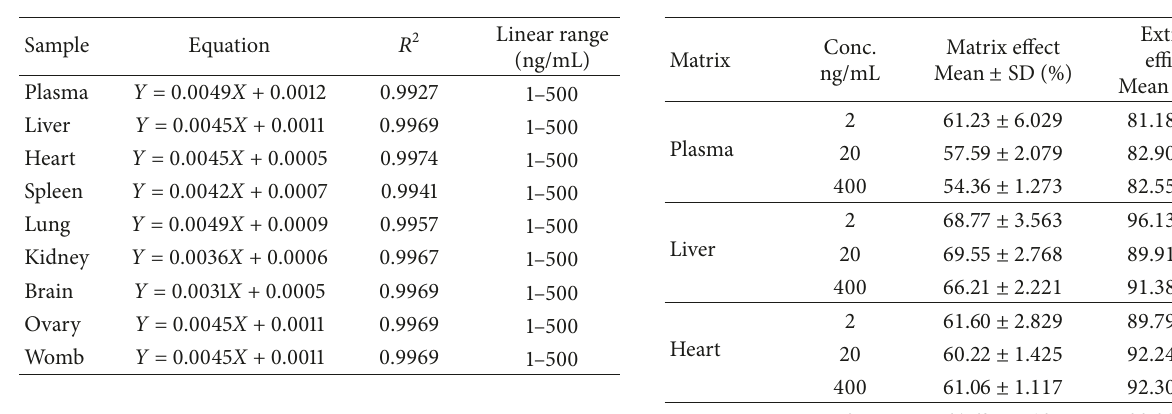
Table 3: Matrix effect and extraction recovery for the assay